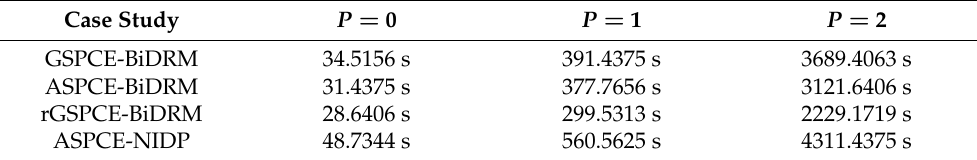
Table 10. Summary of the computational time to quantify uncertainty in model output in Example